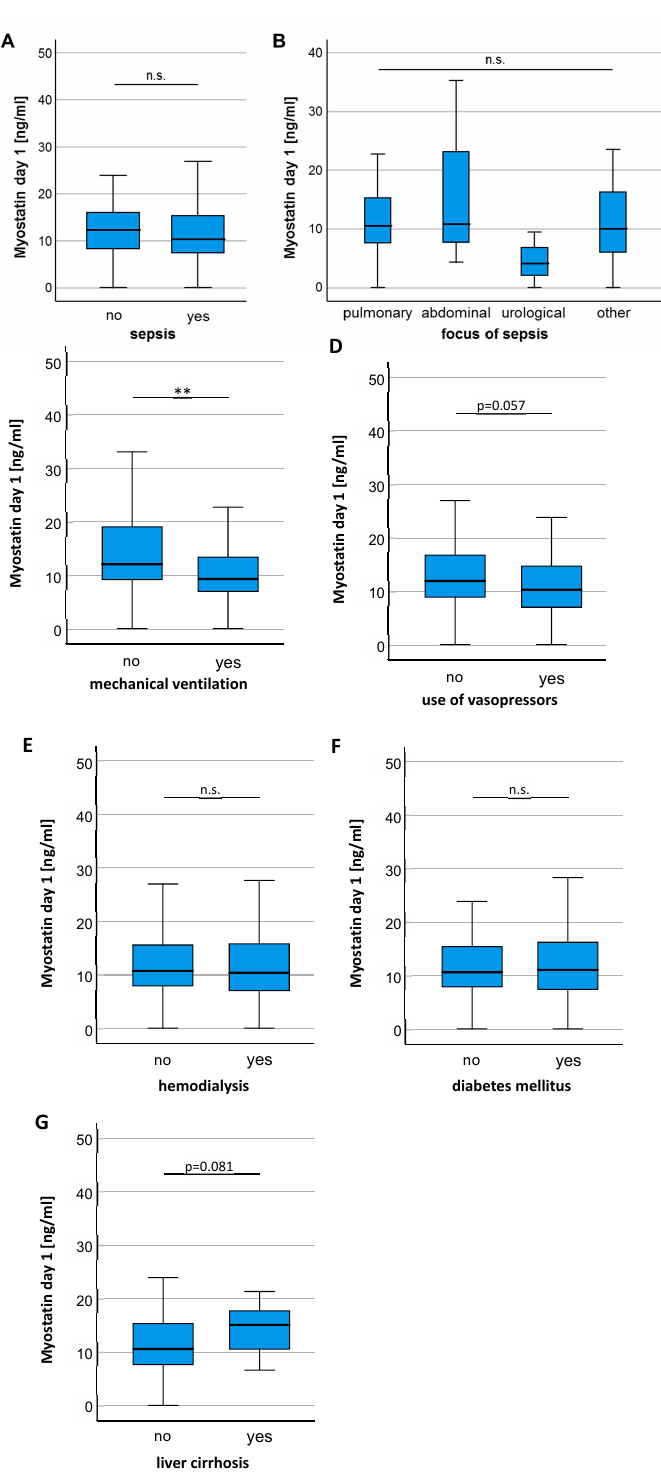
Figure 2. Patients requiring mechanical ventilation show a significant reduction in Myostatin levels. ( A ) Myostatin serum concentrations did not differentiate between patients admitted with or without sepsis. ( B ) Different sites of infections in patients with sepsis did not result in significantly different serum levels of Myostatin. ( C ) Patients requiring mechanical ventilation had significantly lower Myostatin levels and showed a strong trend towards use of vasopressors ( D ). No significant difference in the Myostatin level was found for indication of hemodialysis ( E ), presence of diabetes mellitus ( F ) or liver cirrhosis ( G ). Asterisks indicate p values (Mann-Whitney U-test): ** p < 0.01.